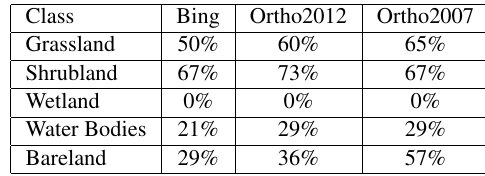
Figure 5. Producer’s accuracy for each LC class in Lombardy